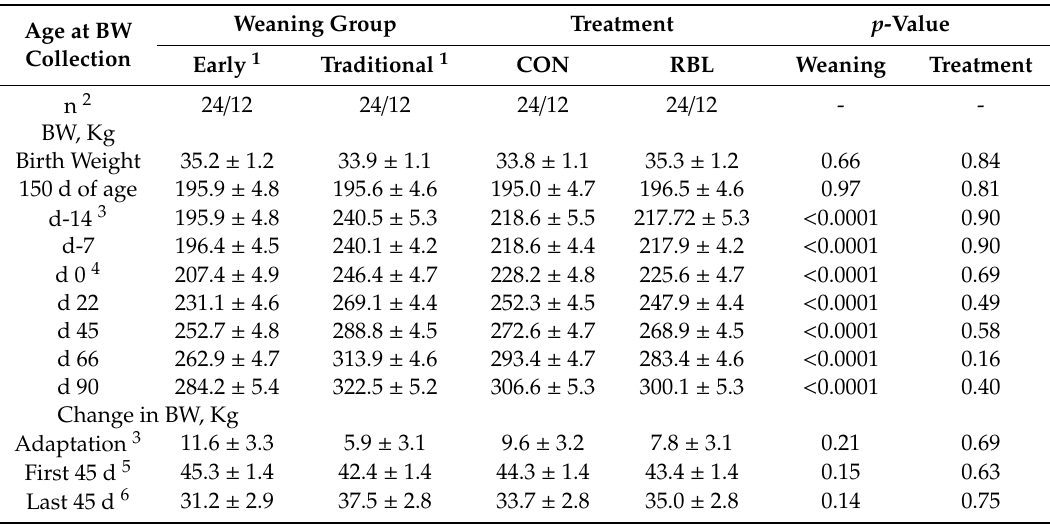
Table 1. Body weight (BW) and change in BW of young steers weaned at di ff erent ages 1 and supplemented a control (CON) or rumen by-pass (RBL)